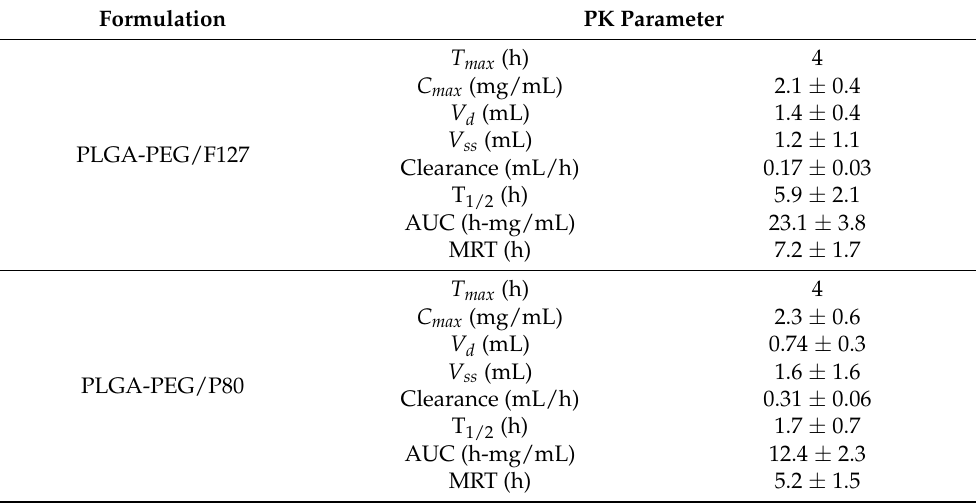
PK parameters are reported as mean ± standard